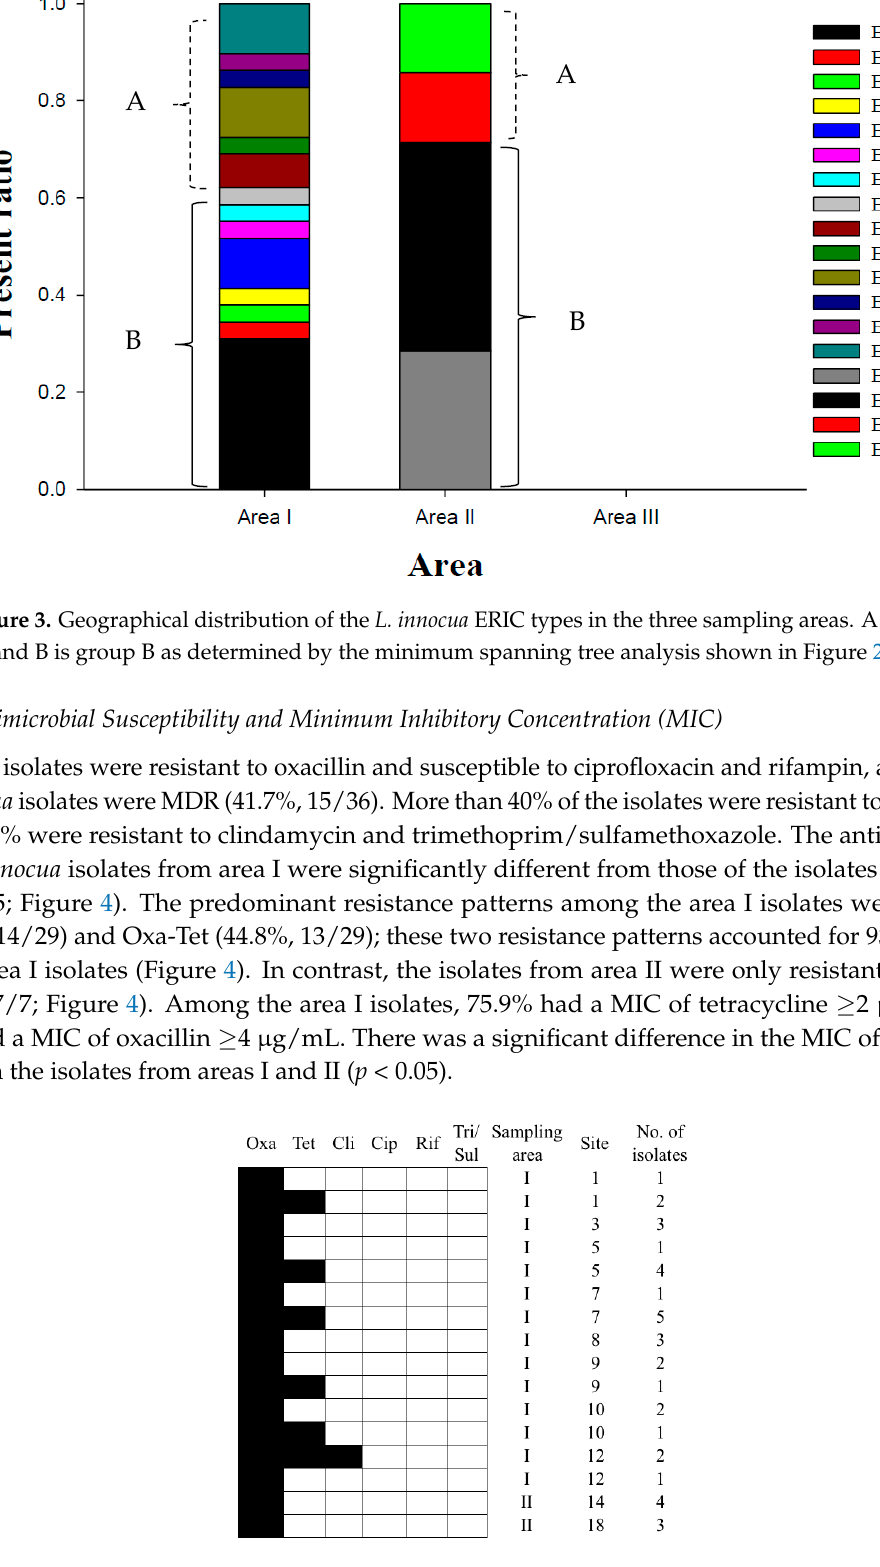
Figure 4. Antibiograms and the source of L. innocua isolates recovered from the Puzi River basin, Taiwan. Black indicates resistant, and white indicates susceptible. Oxa: Oxacillin; Cli: Clindamycin; Tet: Tetracycline; Rif: Rifampin; Cip: Ciprofloxacin; Tri/Sul: